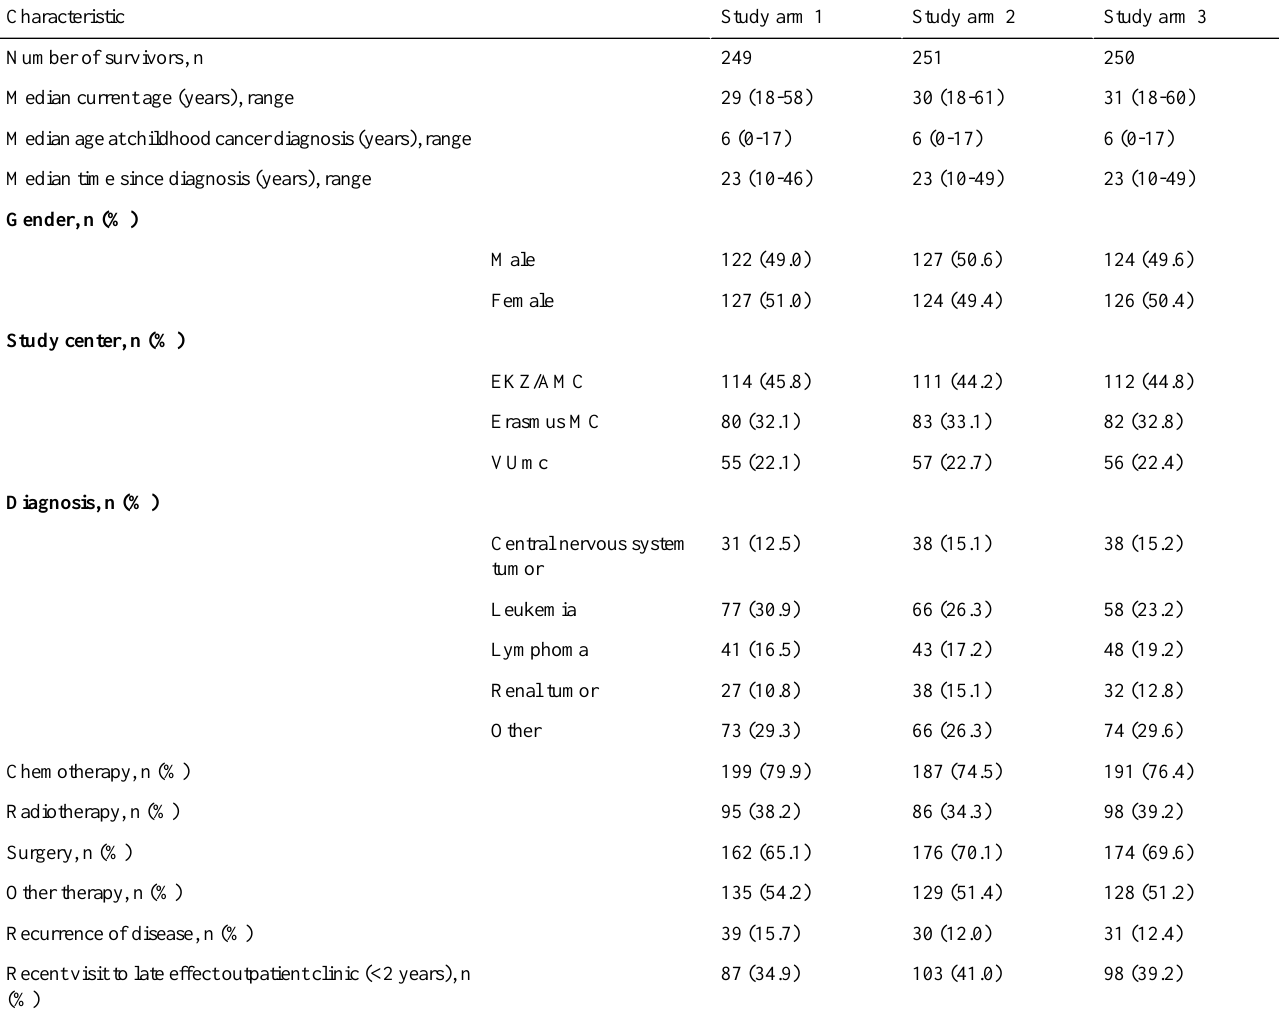
Table 2. Sociodemographic and treatment-related characteristics of the CCSs in each study arm.